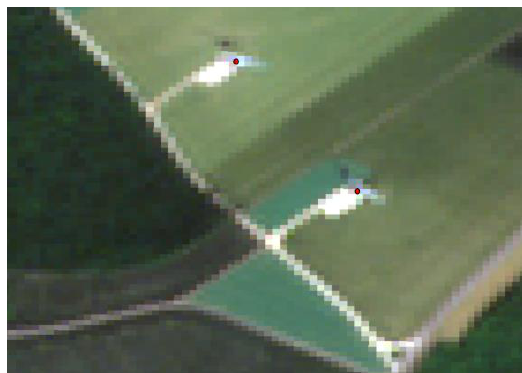
Figure 6 . OSM windmills point overlaid on a Sentinel-2 image.